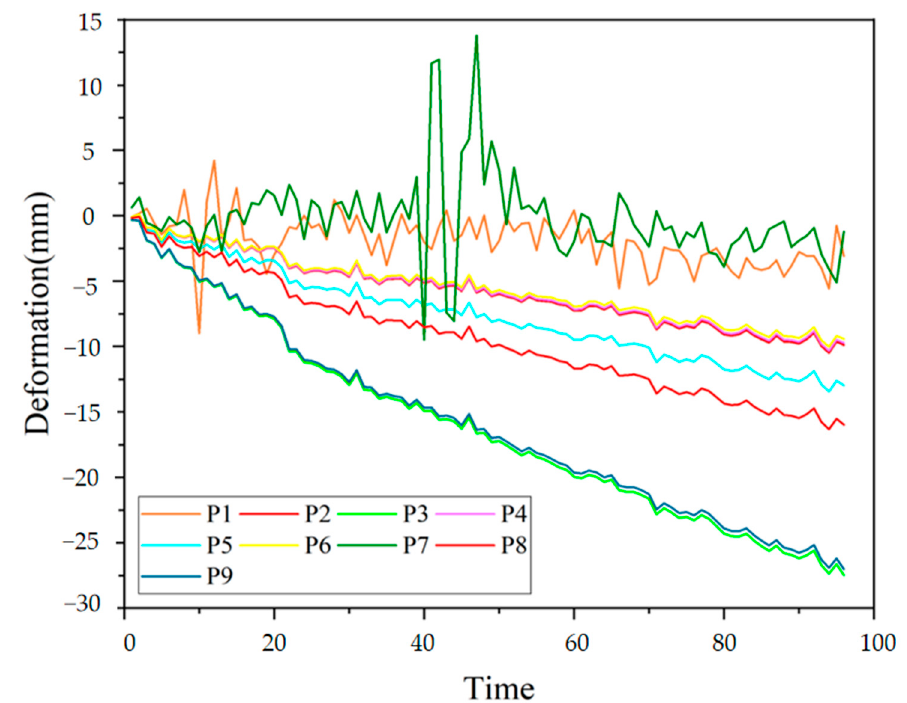
Figure 13. Deformation curve with time of typical points.